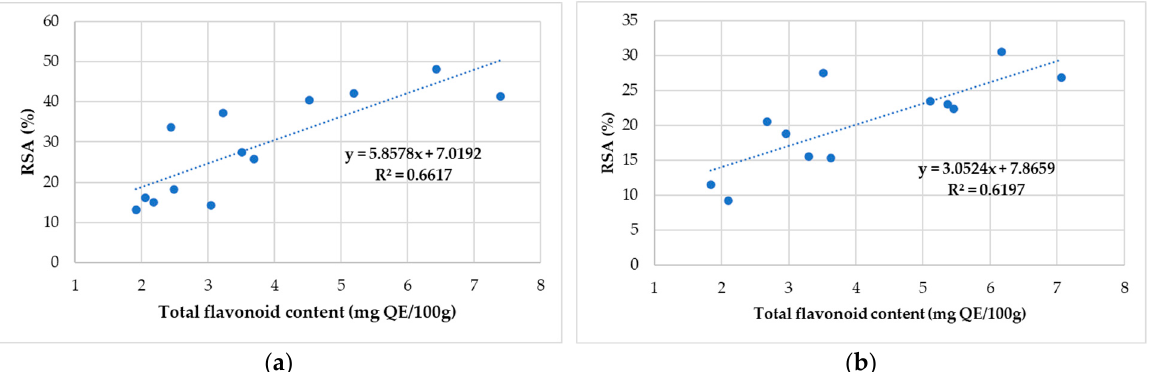
Figure 2. Correlation between antioxidant activity and total flavonoid content of the honey sample collected ( a ) from North-West and Central Romania and ( b ) from Alba County.